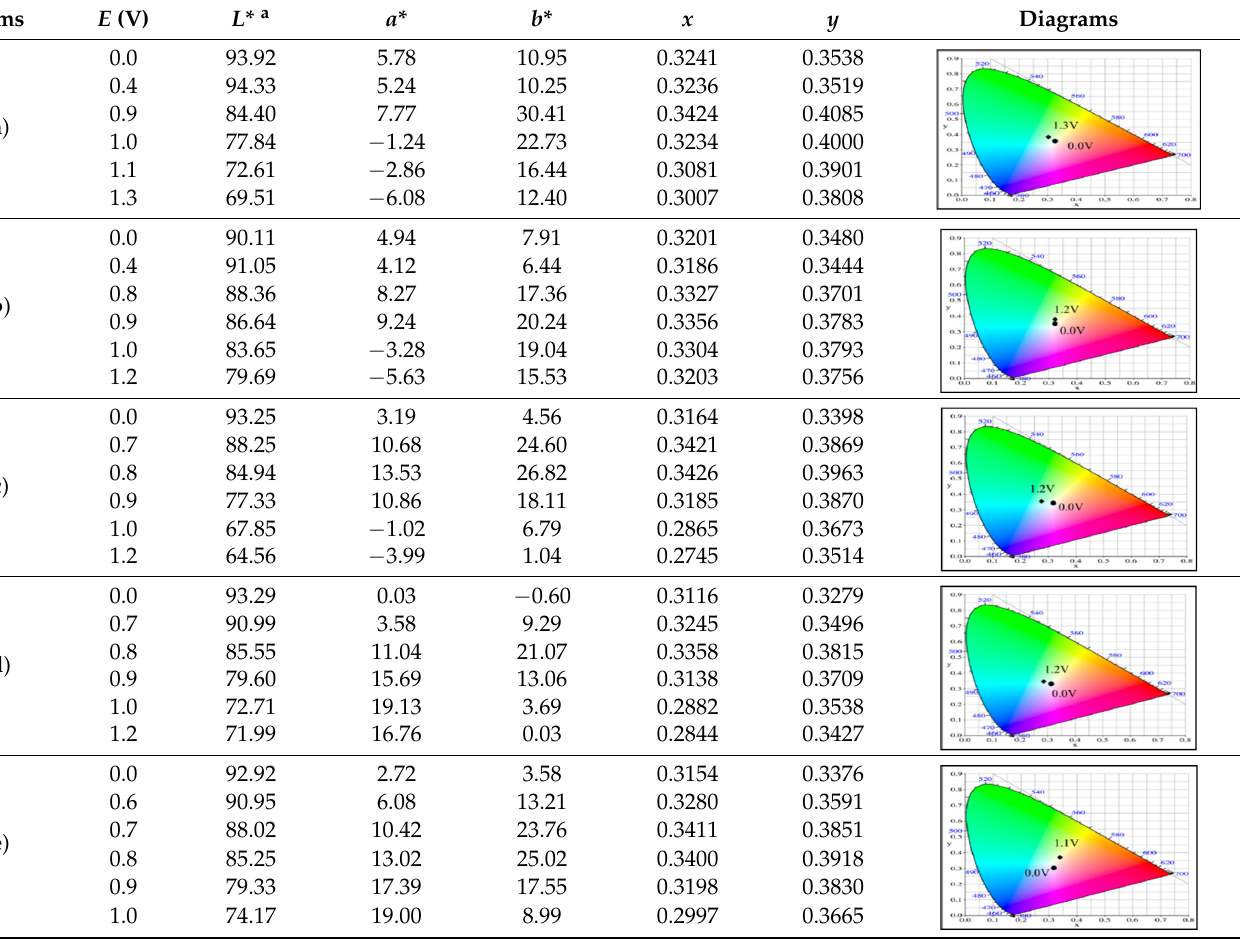
Figure 4. CV curves of ( a-1 ) P(DCB), ( b-1 ) P(DCB -co- ED), ( c-1 ) P(2DCB -co- ED), ( d-1 ) P(DCB -co- EDm) and ( e-1 ) P(2DCB -co- EDm) at different scan rates in a LiClO 4 /ACN solution. ( a-2 )–( e-2 ) show the dependence of currents on the sweep velocities of polymer membranes. Table 2. Chromaticity charts of ( a ) P(DCB), ( b ) P(DCB- co -ED), ( c ) P(2DCB- co -ED), ( d ) P(DCB- co -EDm), and ( e ) P(2DCB- co